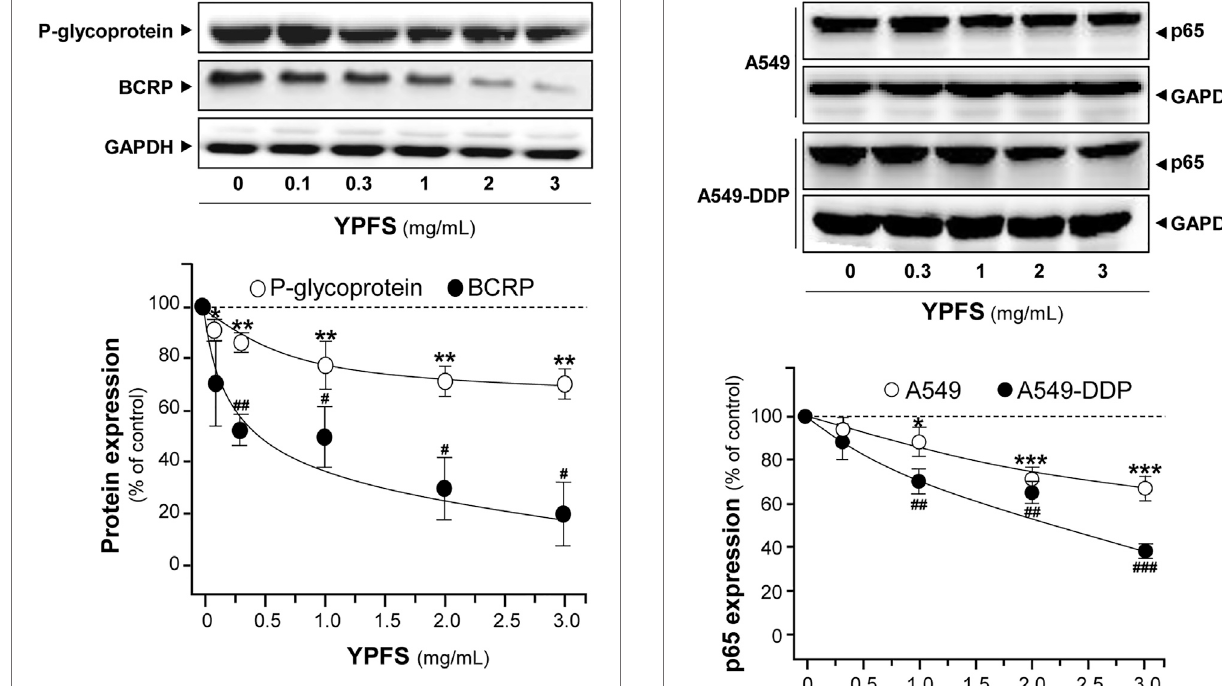
FIGURE5| YPFSsuppressesprotein expressionsofP-gp and BCRP in cultured A549-DDP cells. Cultured A549-DDP cells (120,000/well in 100-mm plate) were treated with YPFS for 48 h. Cell lysates were collected, diluted to equal protein concentration, and analyzed by western blotting. Representative western blots are shown. Values are normalized using the internal control GAPDH and expressed as % of control (untreated culture), in mean ± SEM, n (cid:2) 3. * or # , p < 0.05, ** or ## , p < 0.01, *** or ### , p < 0.001.